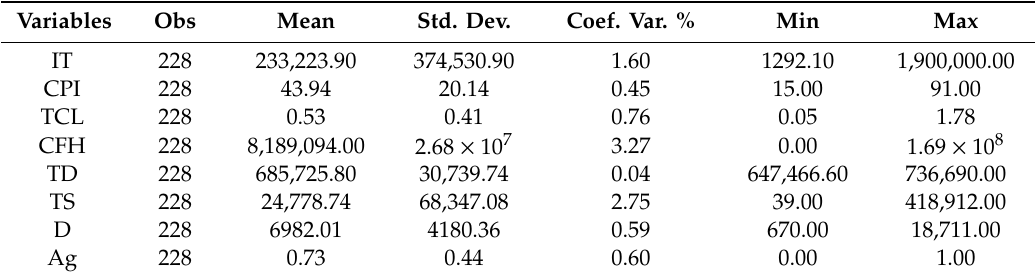
Table 2. Descriptive statistics of EU imports of timber and timber products and the independent variables between 2012 and